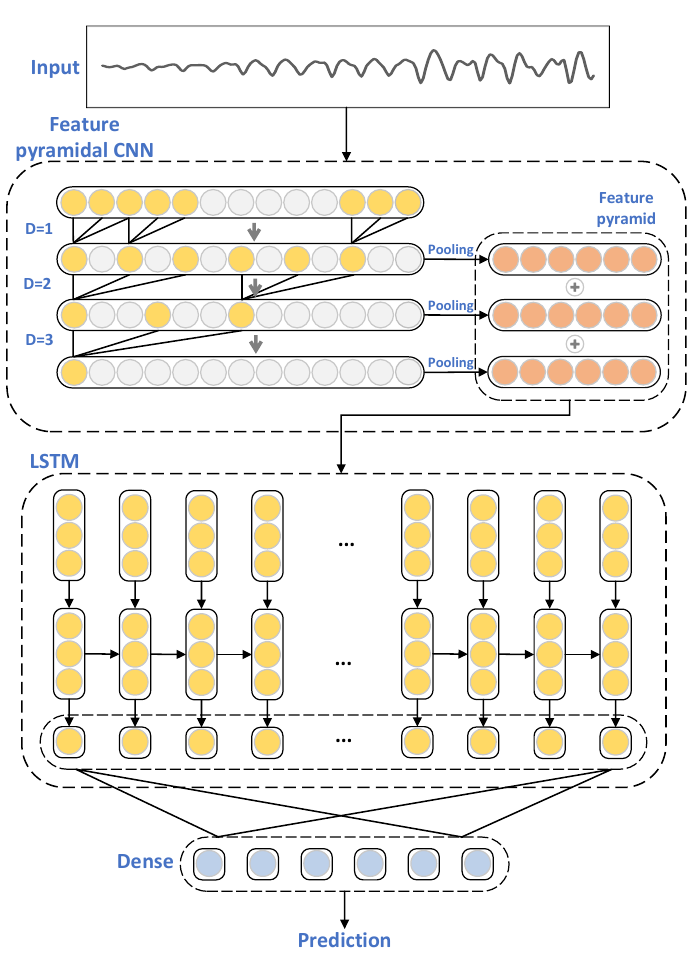
Figure 3. The structure of feature pyramid CNN-LSTM hybrid neural network. Feature pyramid CNN network consists of multiple one-dimensional causal dilation convolutional layers, pooling layers, and feature fusion units. Since the input–output sequences of the causal dilated convolution are of the same length, the input to each convolutional layer is x = [ x ( 1 ) , x ( 2 ) , ..., x ( t )] , and the one-dimensional convolutional